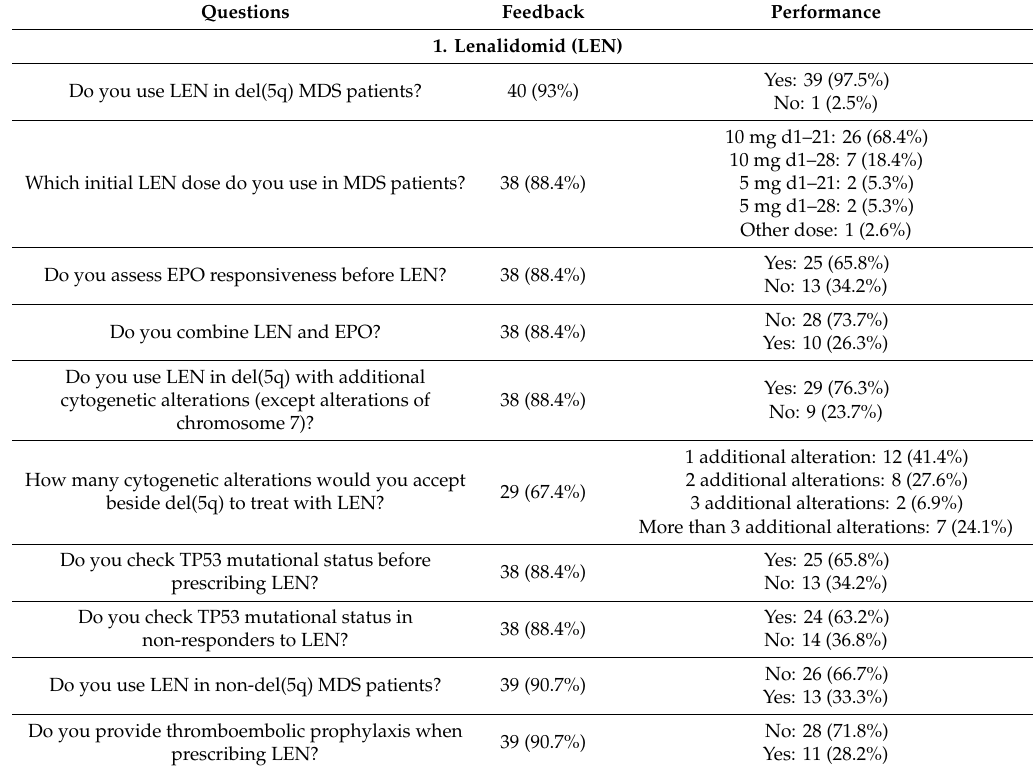
Table 6. Disease-modifying